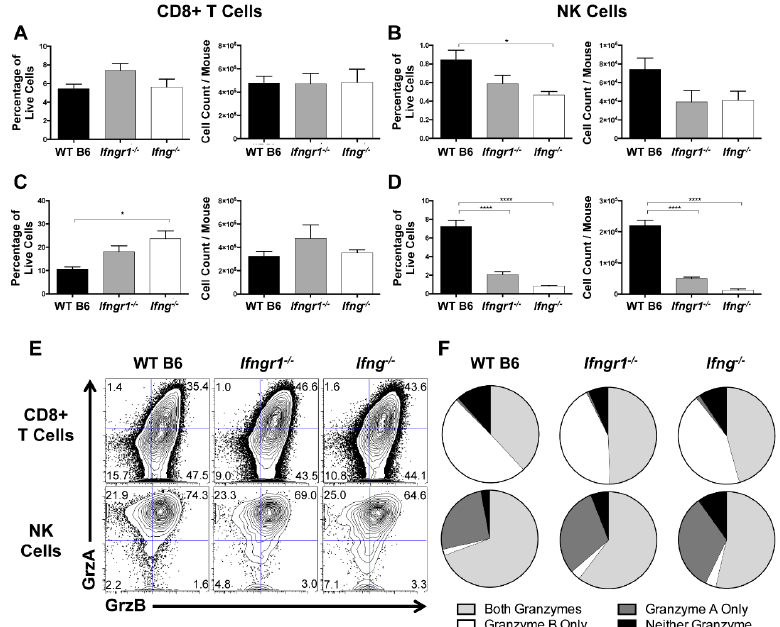
Figure 10. Effect of IFN- γ on CD8 + T cell and NK cell degranulation and cytotoxicity. ( A – D ) Flow cytometry was used to examine the percentage of CD8 + T cells ( A , C ) or NK cells ( B , D ) expressing CD107a, indicative of degranulation, in CLNs ( A , B ) and brains ( C , D ) of WT (black bars), Ifngr1 −/− (gray bars), and Ifng −/− (white bars) mice at 7 DPI ( n = 6–9 pooled mice per time point from four independent experiments; data are presented as the mean ± SEM; * p < 0.05, **** p < 0.0001 by Dunn’s multiple comparisons test). ( E , F ) Contour plots ( E ) show the gating, denoted by blue lines, of CD8 + T cells ( top row of plots ) and NK cells ( bottom row of plots ) for granzyme A and granzyme B production in the brain at 7 DPI. Boolean gating ( F ) was used to determine whether stimulated CD8 + T cells ( top row ) and NK cells ( bottom row ) were producing both granzymes A and B (light gray), granzyme A only (dark gray), granzyme B only (white), or neither of the granzymes (black) at 7 DPI ( n = 6–9 pooled mice per time point from three independent experiments; data are presented as the mean).